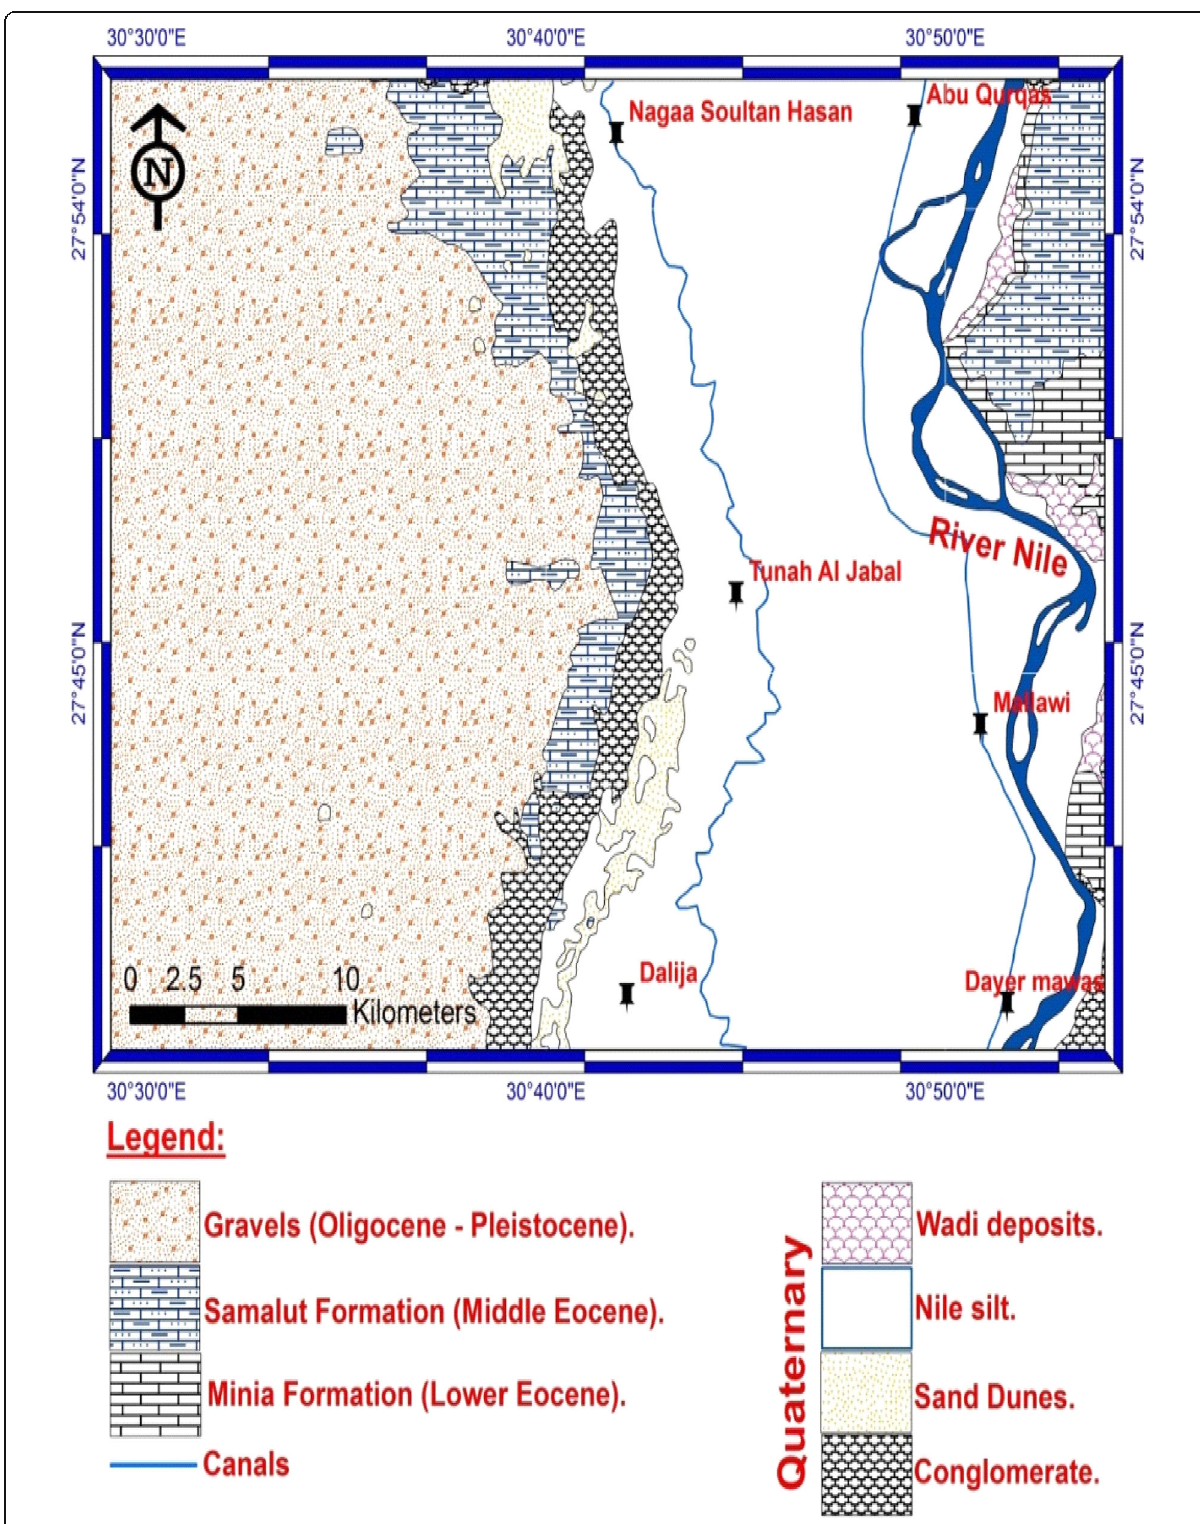
Fig. 2 Geologic map of the study